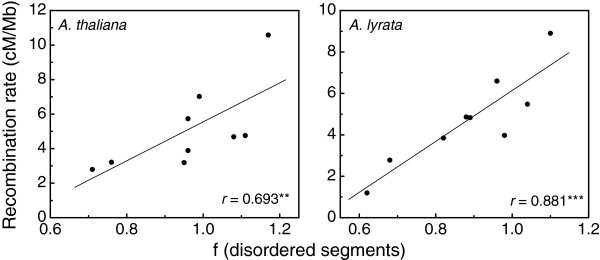
Scatter plot of frequency of disordered segments in proteins encoded in translocated genomic regions of A. thaliana and A. lyrata (X-axis) versus recombination rates of the corresponding chromosomic regions (Y-axis). A protein segment is considered disordered if it contains a contiguous stretch of predicted disordered residues of L ≥ 30 amino acids. Statistical significance of Pearson correlation is indicated with *** and **, which correspond to p < 0.005 and p < 0.01, respectively.